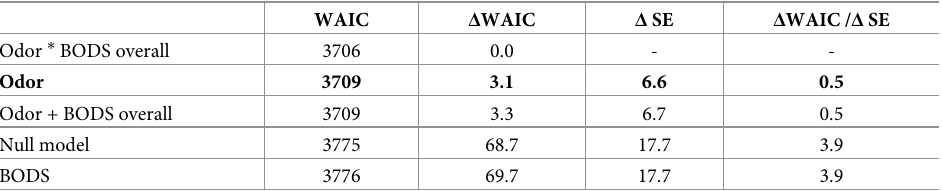
Models are presented from lowest (top row) to highest WAIC value (bottom row) and the best model is marked in bold. WAIC—widely applicable information criterion; Δ WAIC–WAIC difference (vs. model in the top row); Δ SE— standard error of the WAIC difference. BODS overall–body odor disgust sensitivity overall score. The null model included gender and random intercepts for each participant * Indicates an interaction effect and + an additive